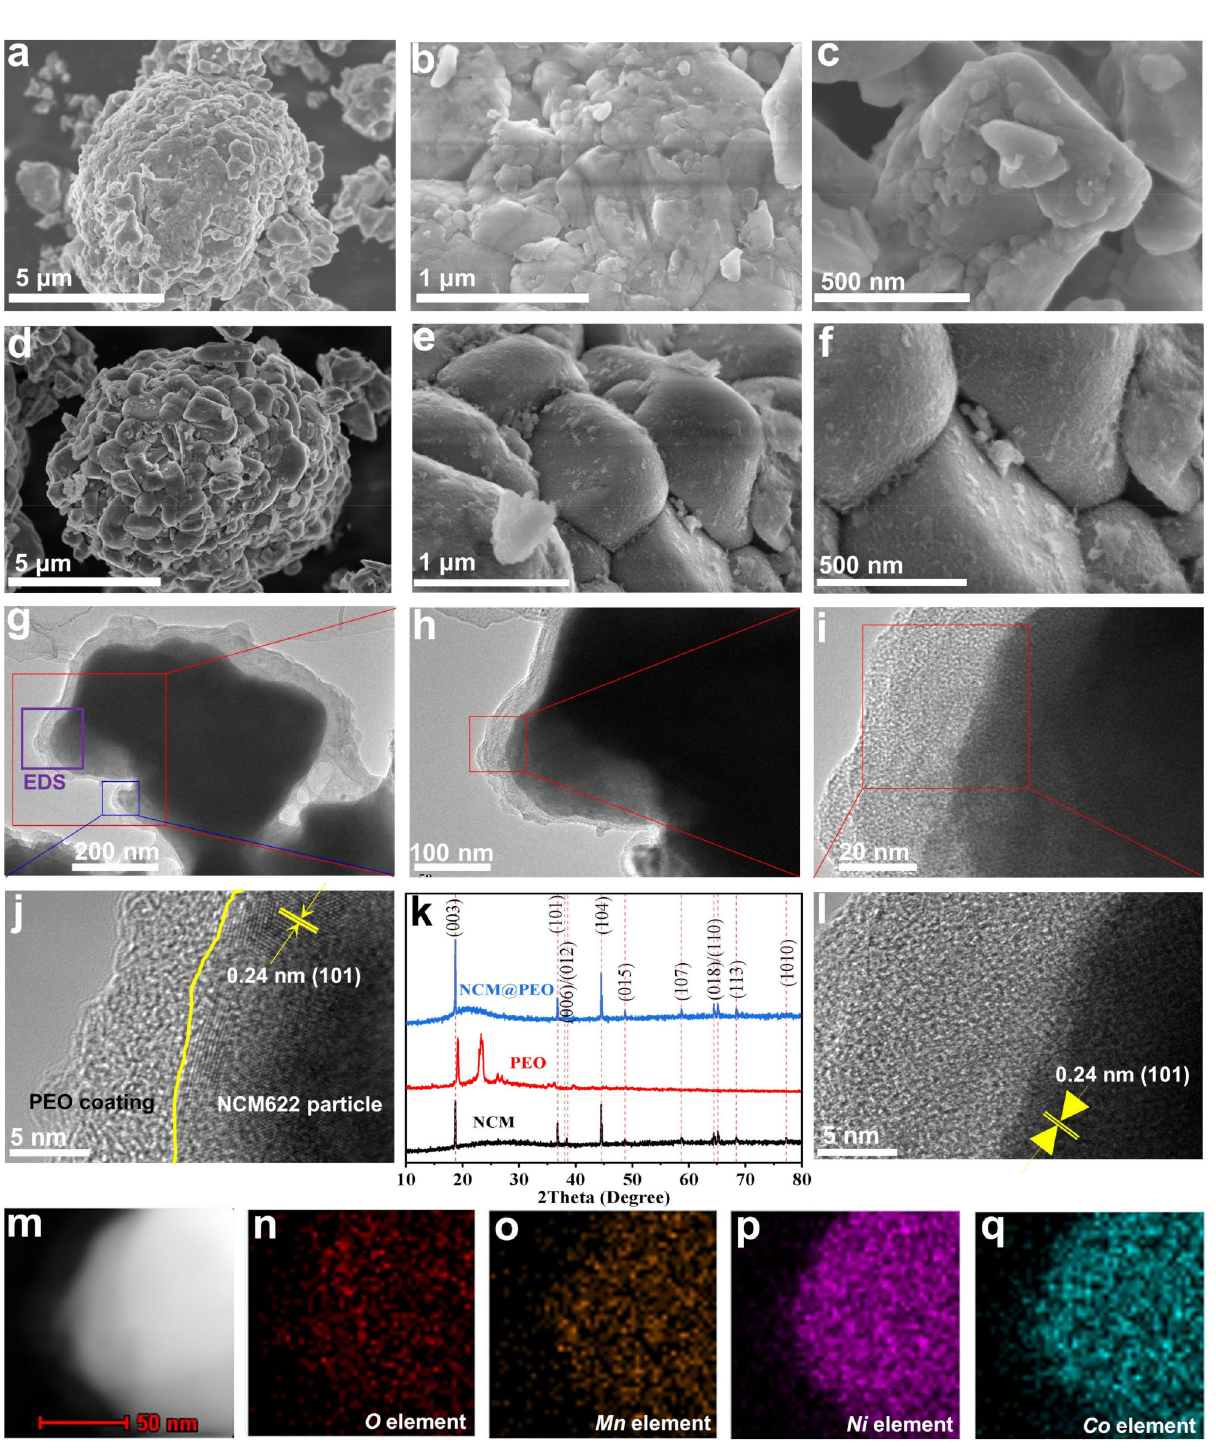
Figure 3. ( a – c ) SEM image of the pristine NCM622 particles and ( d – f ) the PEO-coated NCM622 particles, ( g – j , l ) TEM images of the PEO-coated NCM622 particles, ( k ) XRD patterns of the pristine NCM622 particles, PEO and the PEO-coated NCM622 particles, and ( n – q ) the EDS mapping of the elements of O, Mn, Ni and Co in the corresponding TEM image ( m ),